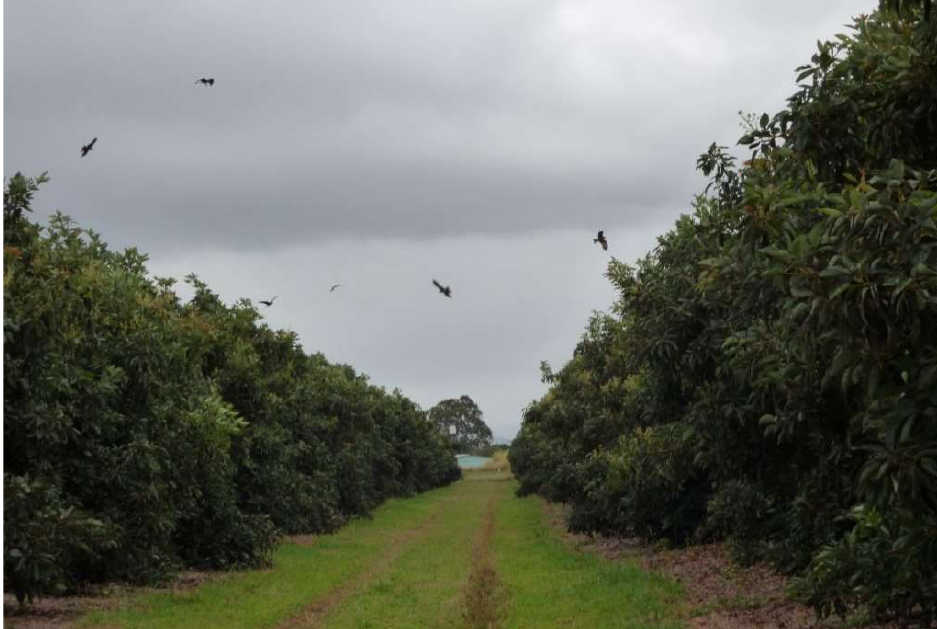
Figure 1. Black Kites circling avocado orchards, Mareeba, Queensland, Australia. Photo: Jack Leighton.